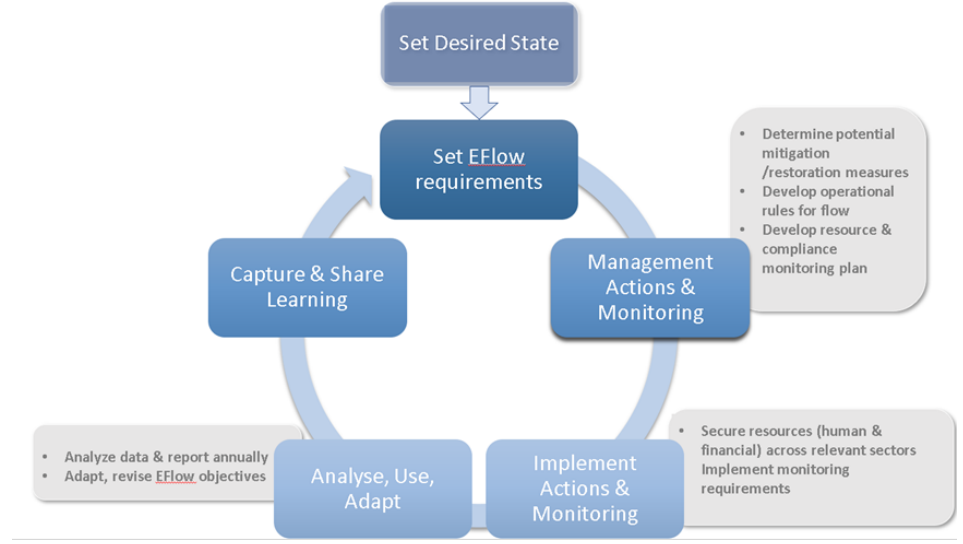
Figure 4. Process for implementing estuarine ecological flows in an adaptive management cycle.